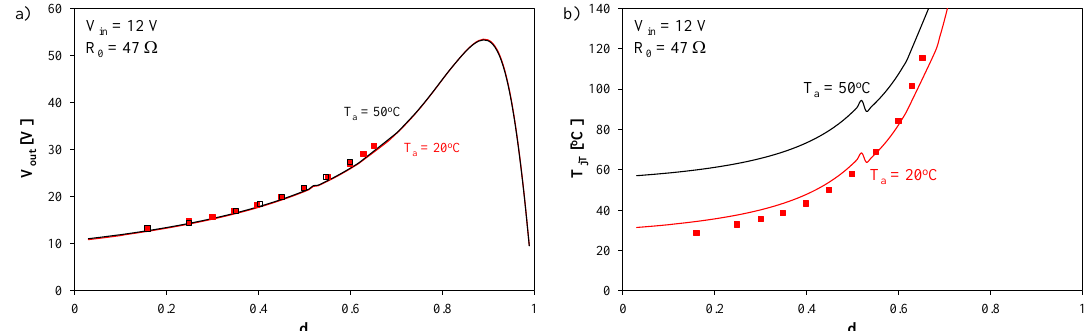
Figure 17. Computed and measured dependences of converter output voltage ( a ) and internal temperature of the diode ( b ) on duty cycle.